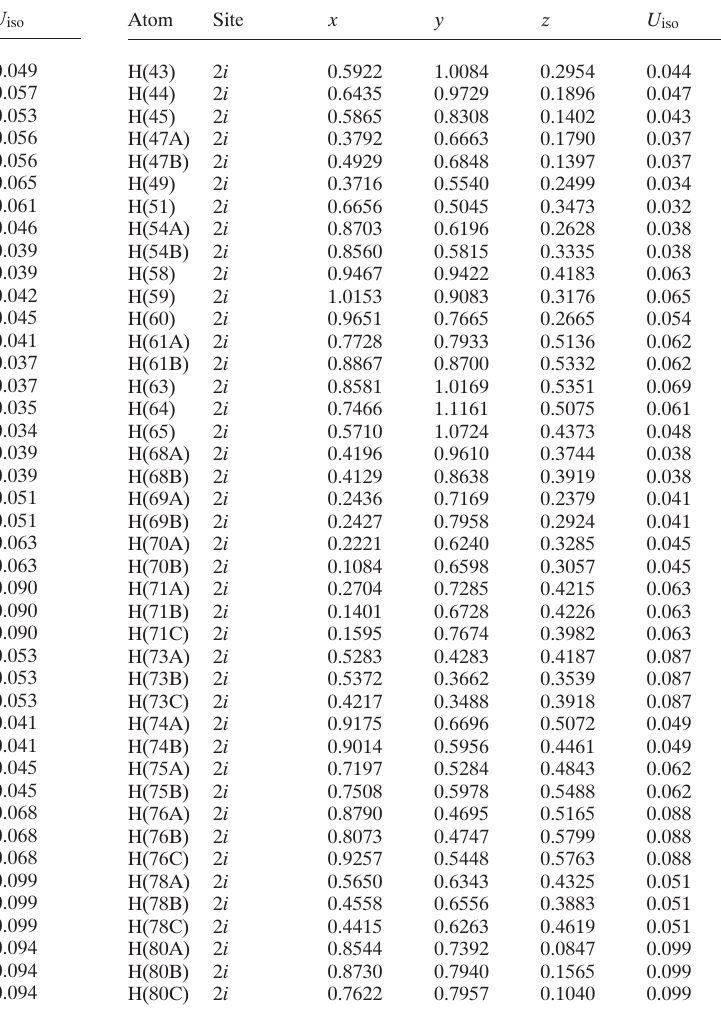
Table 2. Atomic coordinates and displacement parameters (in Å 2 )